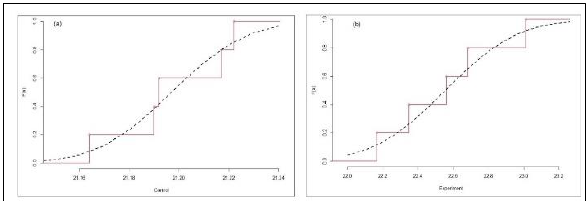
Figure 12. Experimental plot to show the normality of the data of (a) control area and (b) test